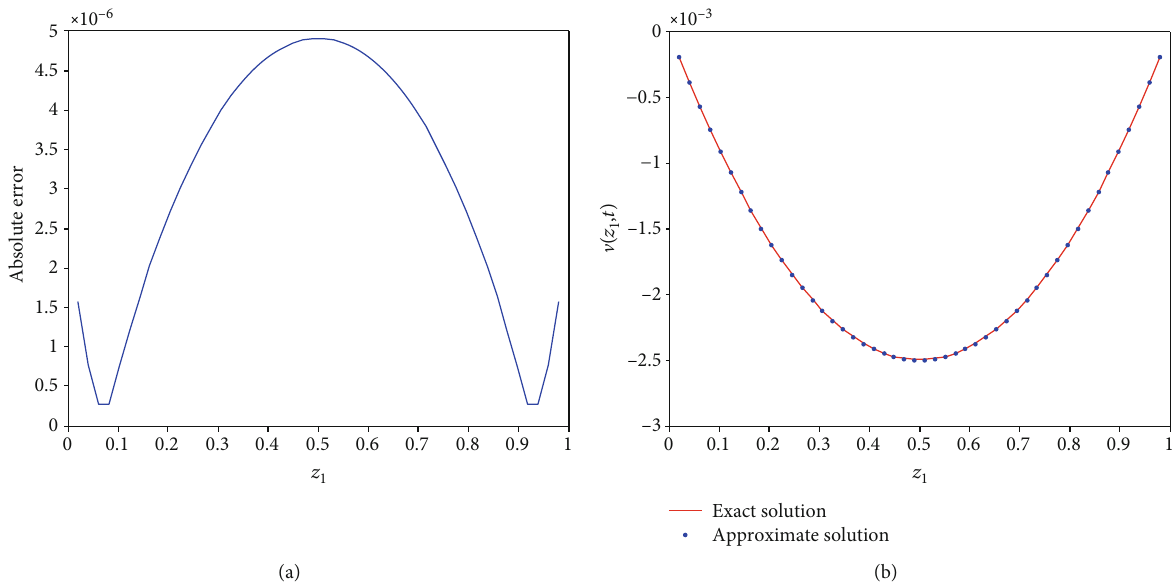
Figure 8: (a) E (b) exact and approximate solution for α = 1 : 15 for the Problem abs